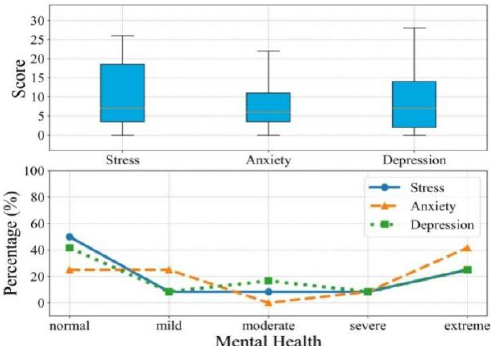
Figure 4. Distribution of mental health problems. ( Top ) Boxplots of the distribution of scores for the three mental states of the participants; ( Bottom ) The proportion of the number of participants according to the severity of the three psychological problems measured by the participants.